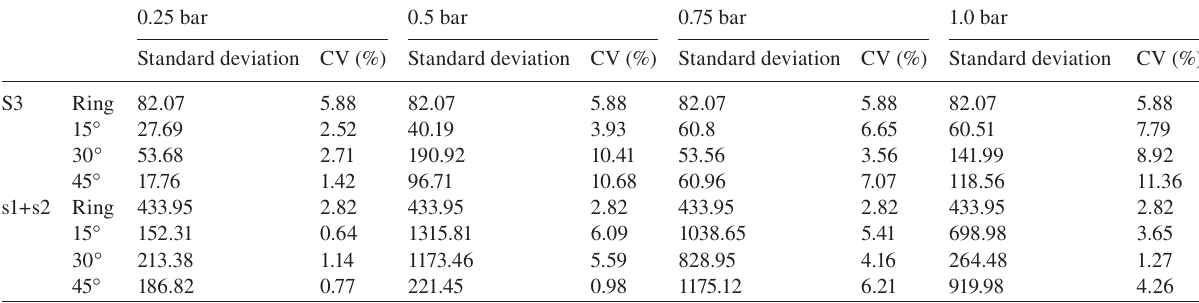
Table 7 Standard deviation and coeffi cient of variation (CV) values of hairiness test results.